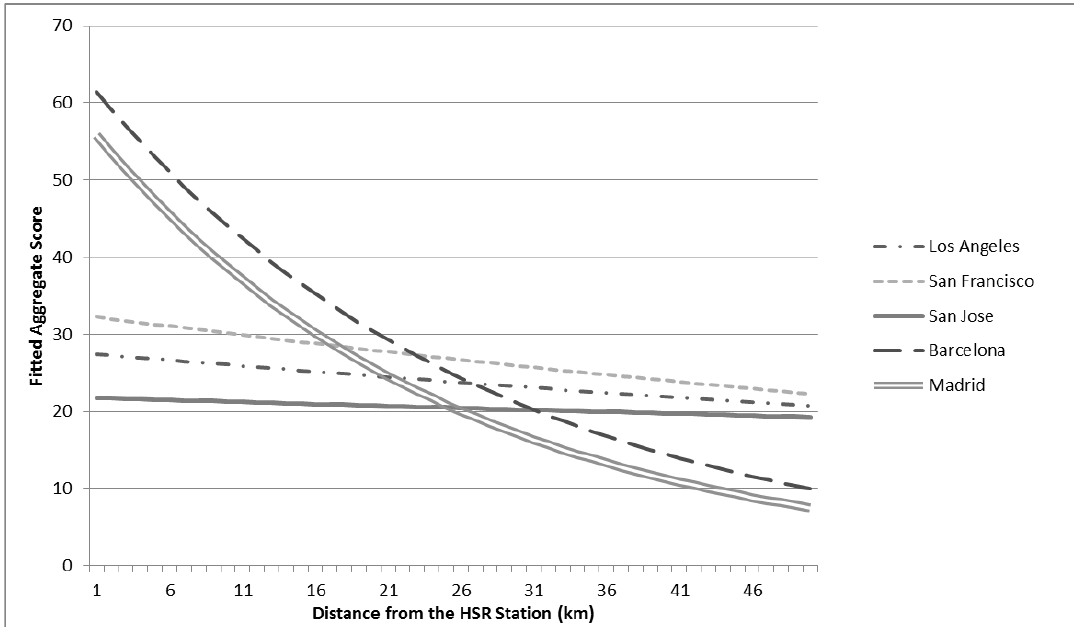
Figure A-1. Aggregate Score Gradient for HSR Accessibility of Study Cities (based on gradient estimates of the sensitivity